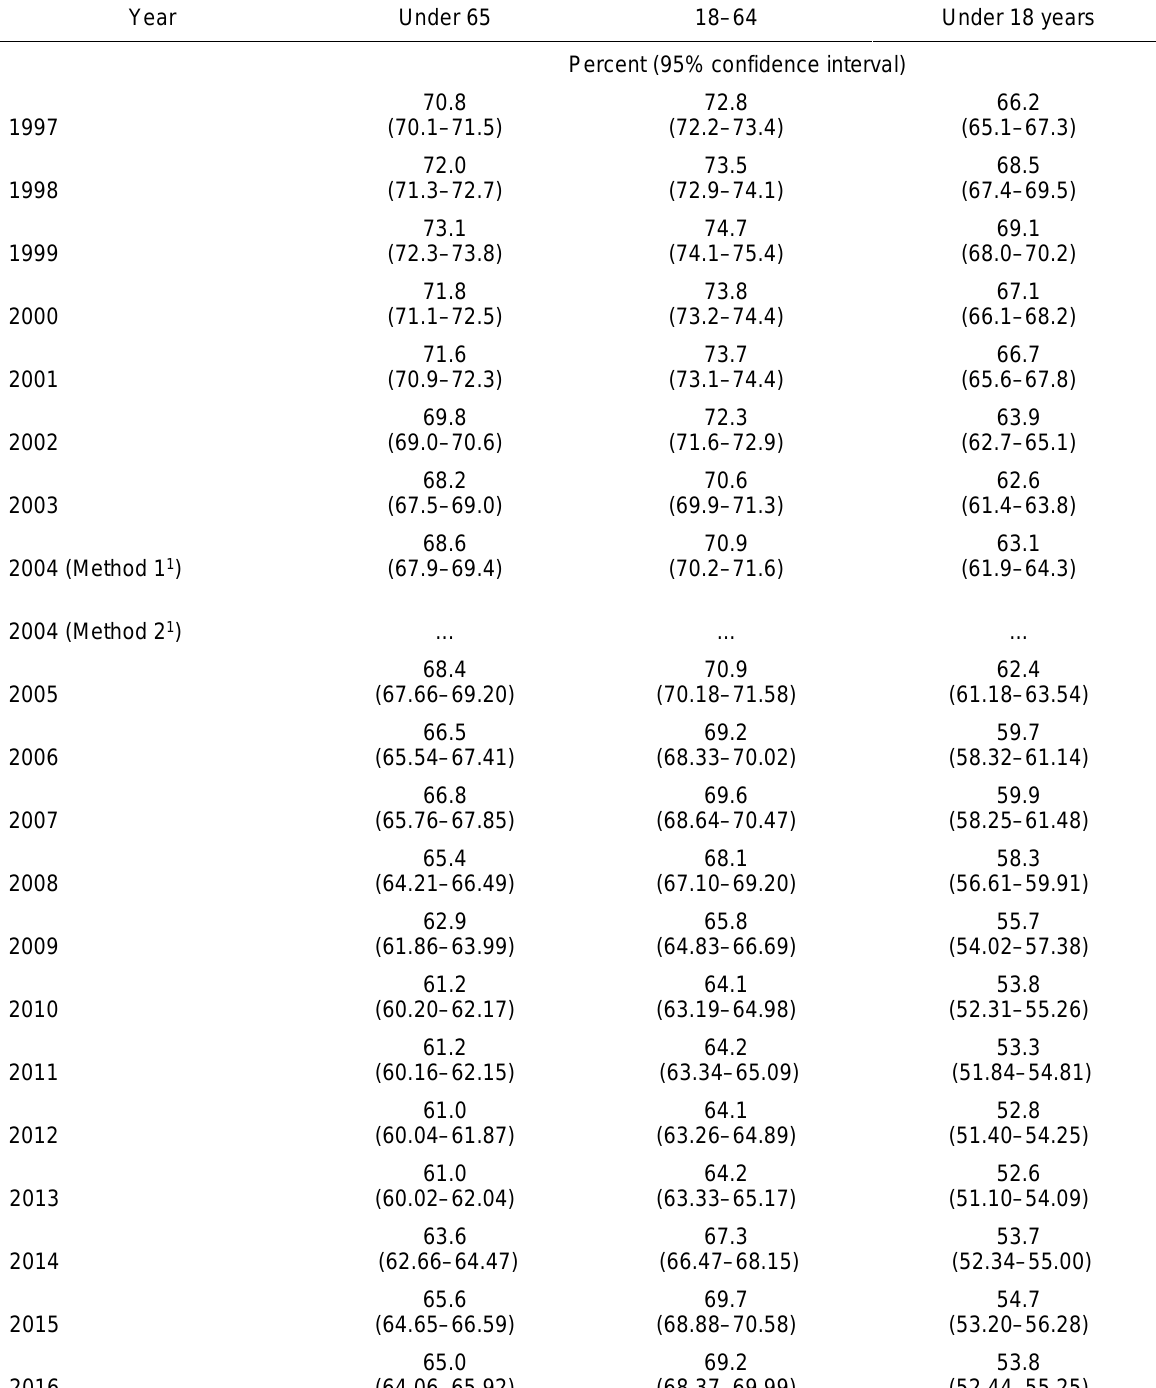
Table 1.2b. Percentage of persons under age 65 with private health insurance coverage, by age group: United States,